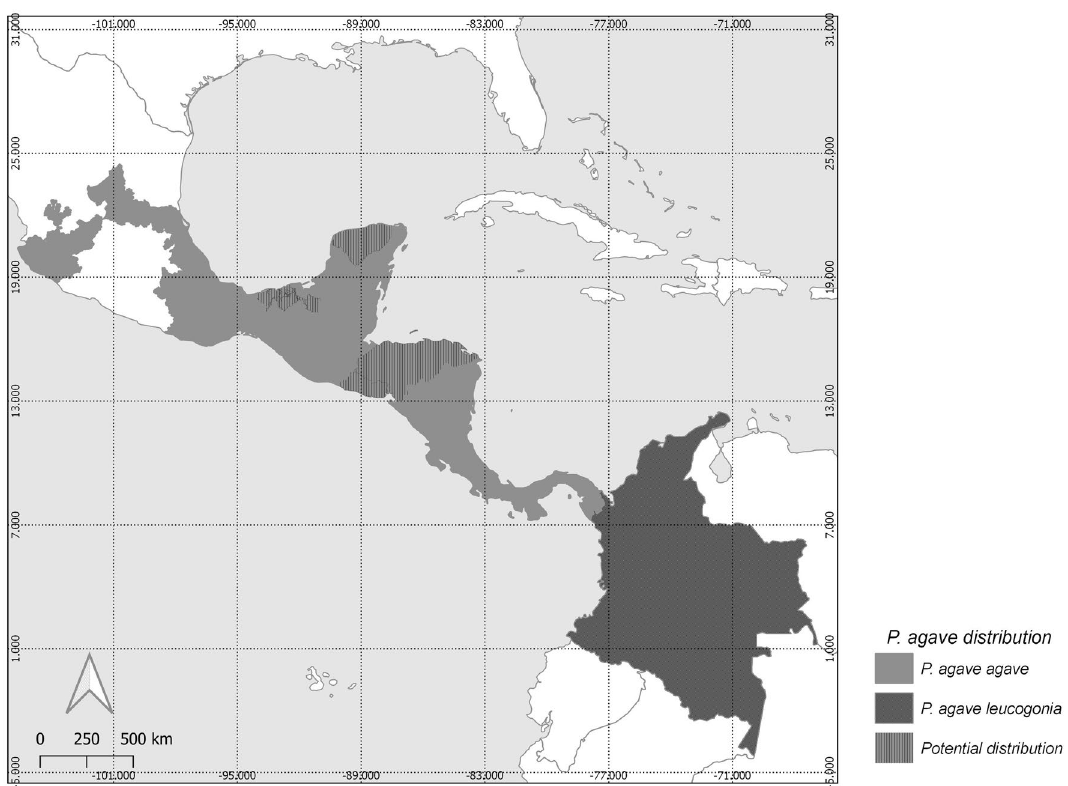
Figure 4. Known distribution of Pseudonymphidia agave . Records were compiled from published literature, Museum databases and internet catalogs (see Material and methods for more details). Map created using the free and open source QGIS, version 3.12.0, http:// www. qgis. org. Map credit: B. R.